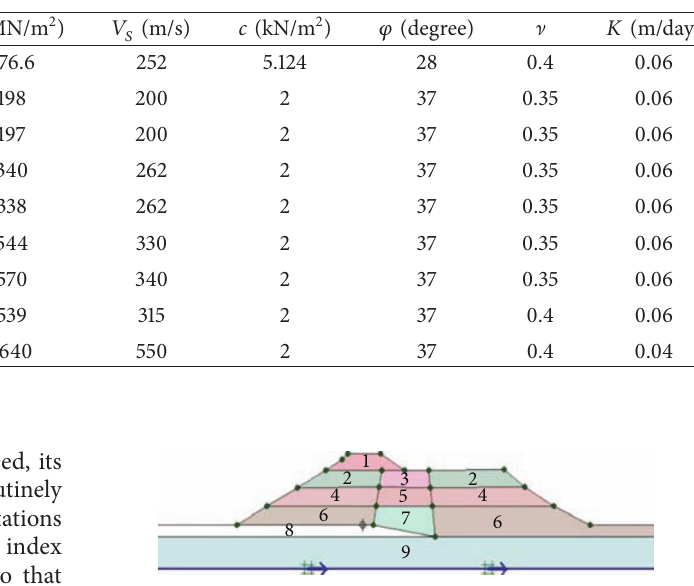
Figure 1: Cross section and layers of Upper San Fernando dam.